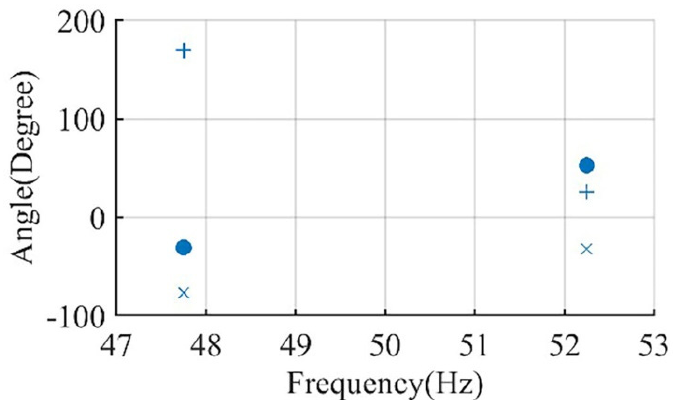
Figure 10. Motor II vector representation of left sideband and right sideband components for; inertia of 16.84 kg·m 2 (+), HBBR at 16.84 kg·m 2 (×), and HBBR at 0.042 kg·m 2 (circle).